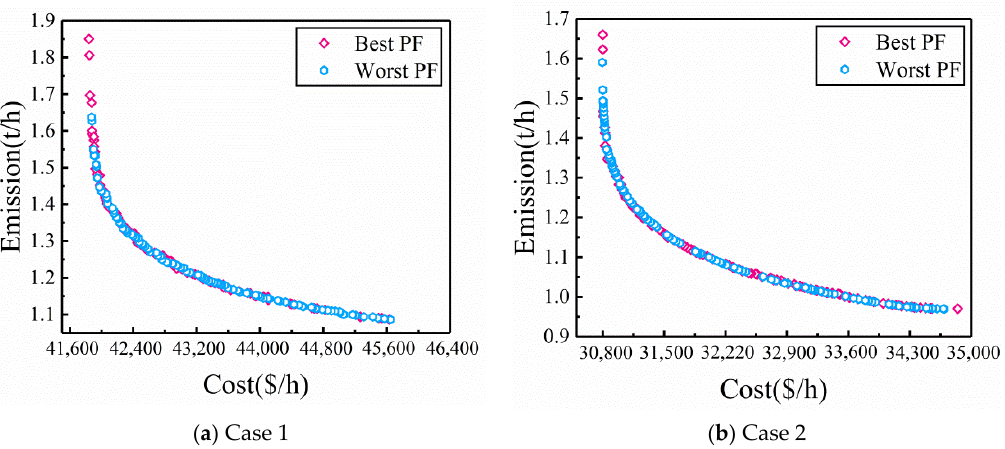
Figure 7. The comparison of the PFs of all methods in case 2.